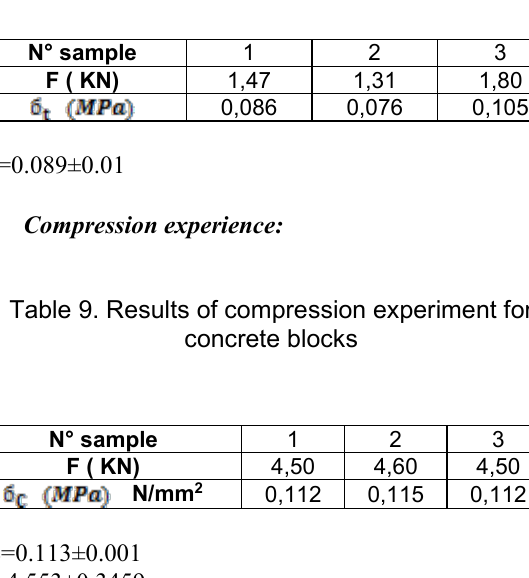
Table 8. Results of the tensile experiment of polyester building blocks